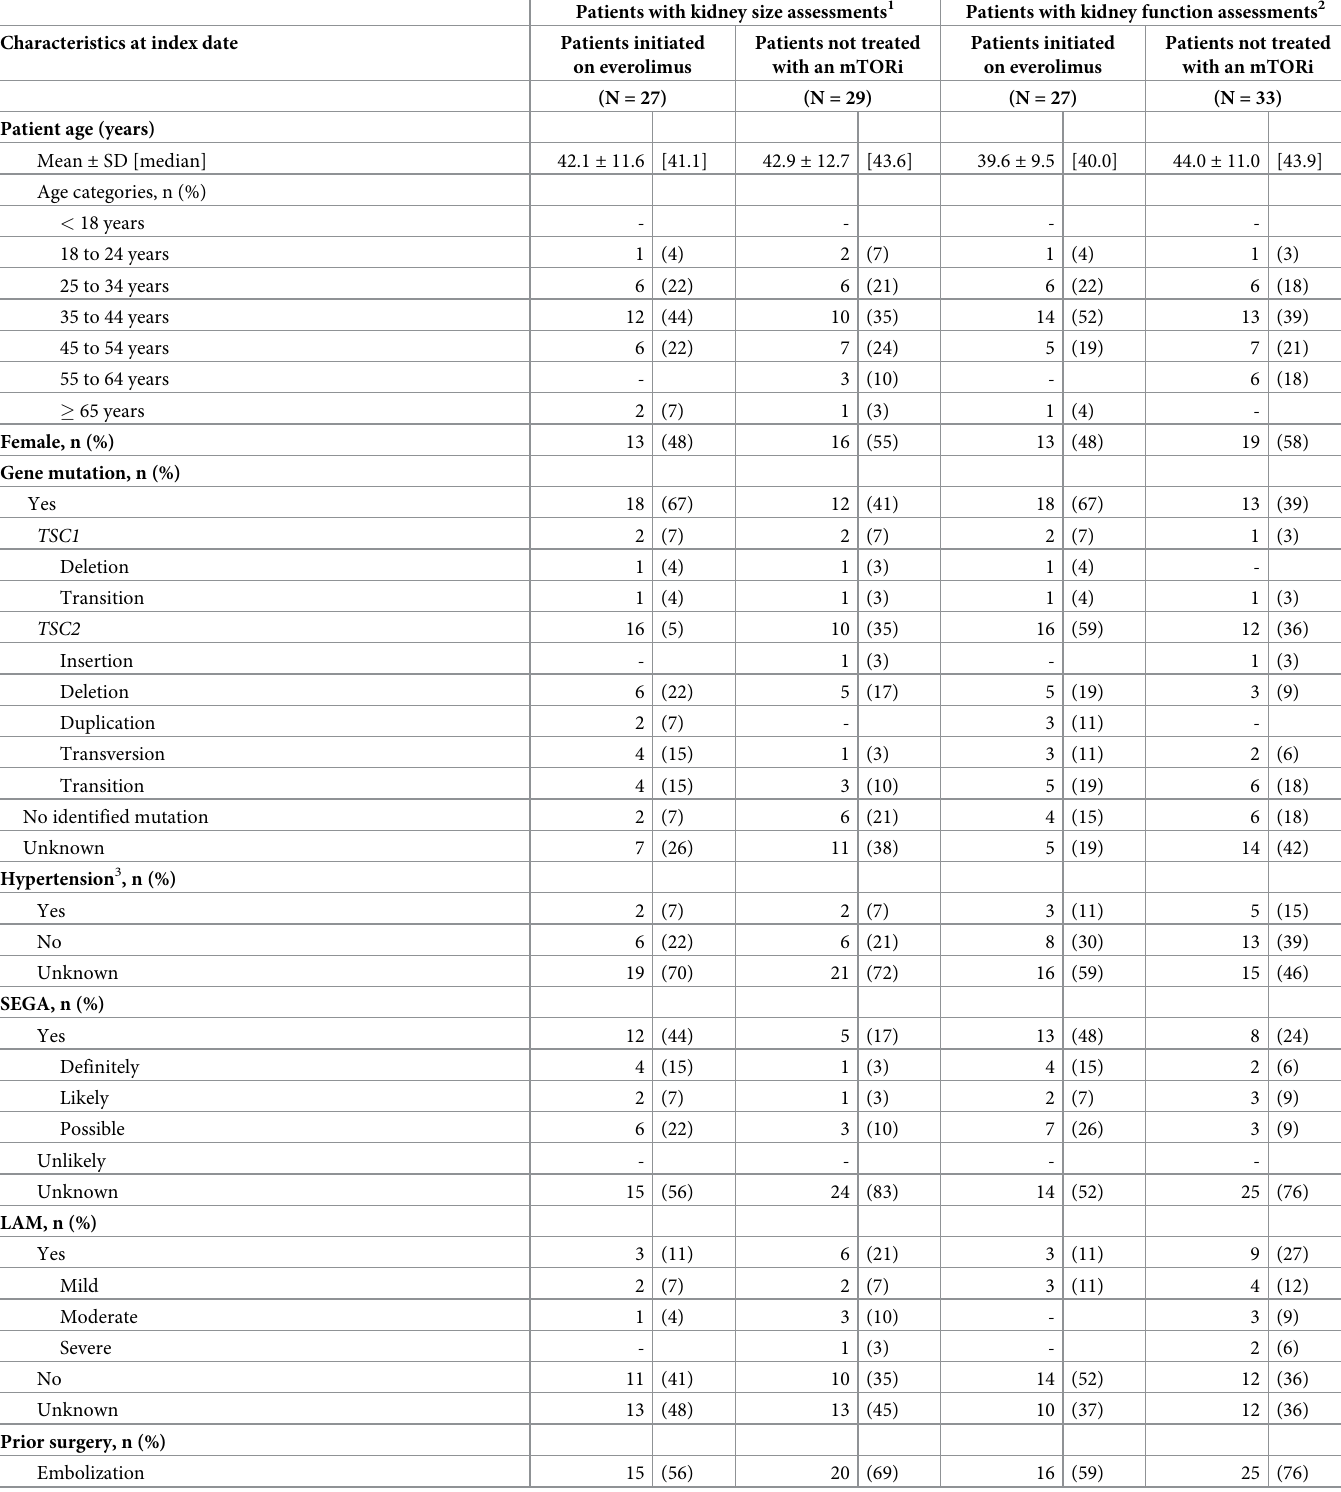
Table 3. Patient demographics and clinical characteristics at index date or